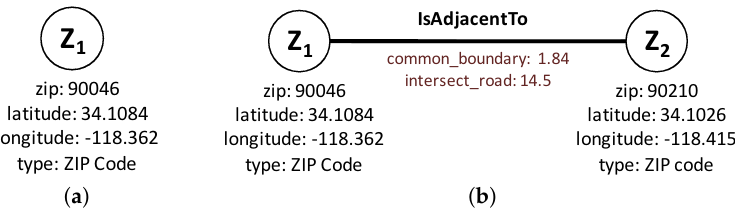
Figure 6. Graph data modeling-proximity computation. ( a ) ZIP code node; ( b ) IsAdjacentTo Edge.